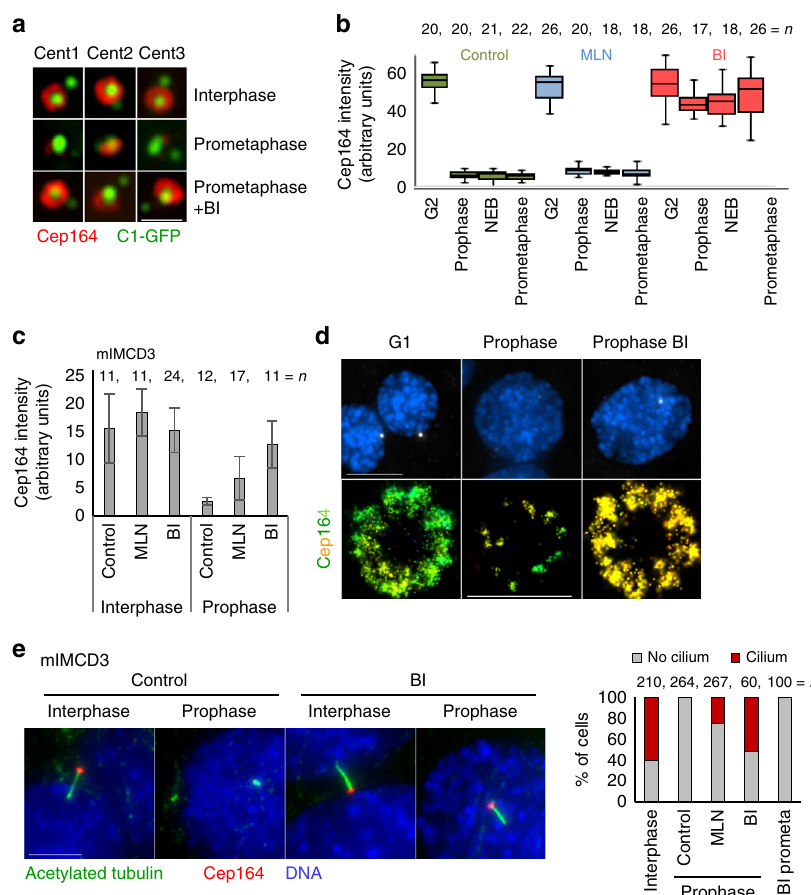
Fig. 7 Plk1 and Aurora A modulate pre-mitotic DAP dynamics. a Examples of older mother centrioles from HeLa cells under different experimental conditions. Inhibition of Plk1 for 4 h (BI) prevents the loss of Cep164 from centrioles in early mitosis. b Quanti fi cation of Cep164 associated with older mother centrioles in HeLa cells after Plk1 (BI) and Aurora A (MLN) inhibition. A median line and upper and lower quartile is presented in